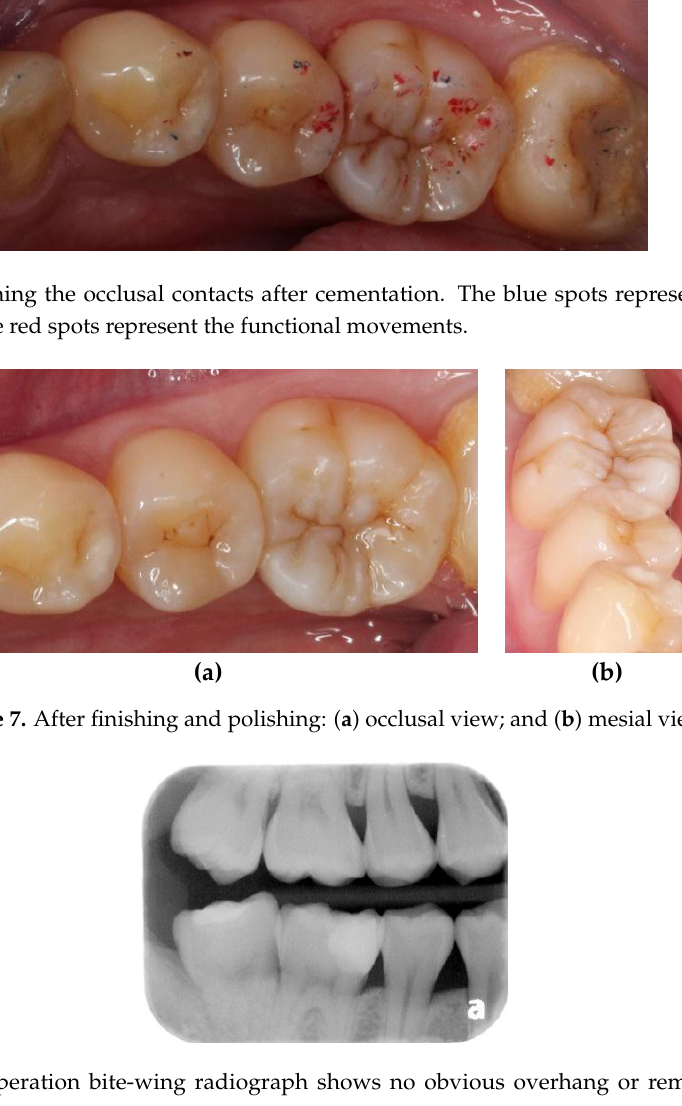
Figure 8. Post-operation bite-wing radiograph shows no obvious overhang or remaining excess resin cement.